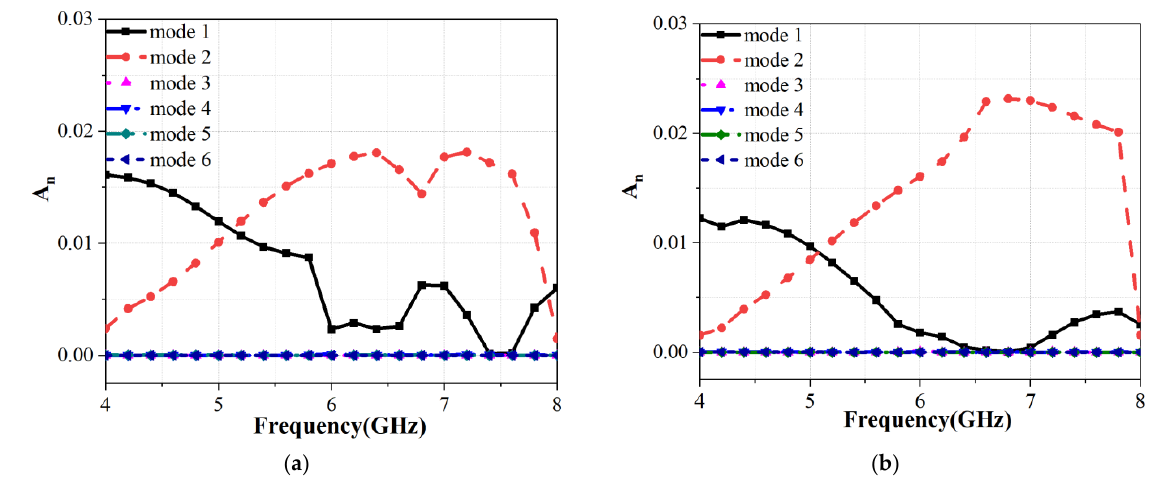
Figure 15. 𝐴 𝑛 of scattering characteristic modes of the reference antenna and antenna A. ( a ) Antenna A; ( b ) antenna B.